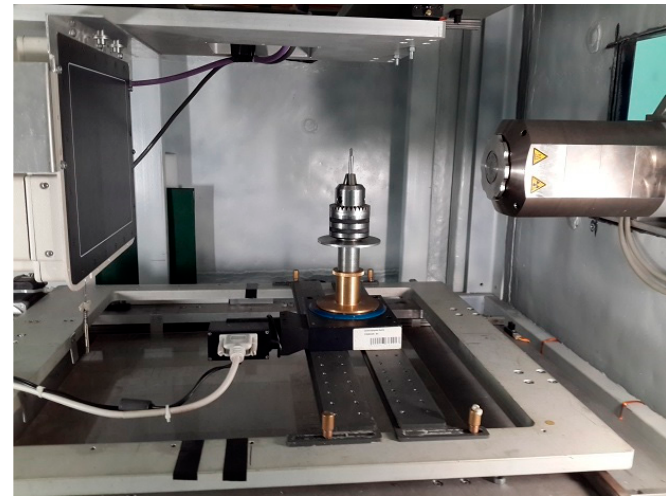
Figure 2. A photograph of XCT system Orel-MT [27]. Table 1 summarizes the Orel-MT speci fi cations. Table 1. XCT system Orel-MT speci fi cations [27].